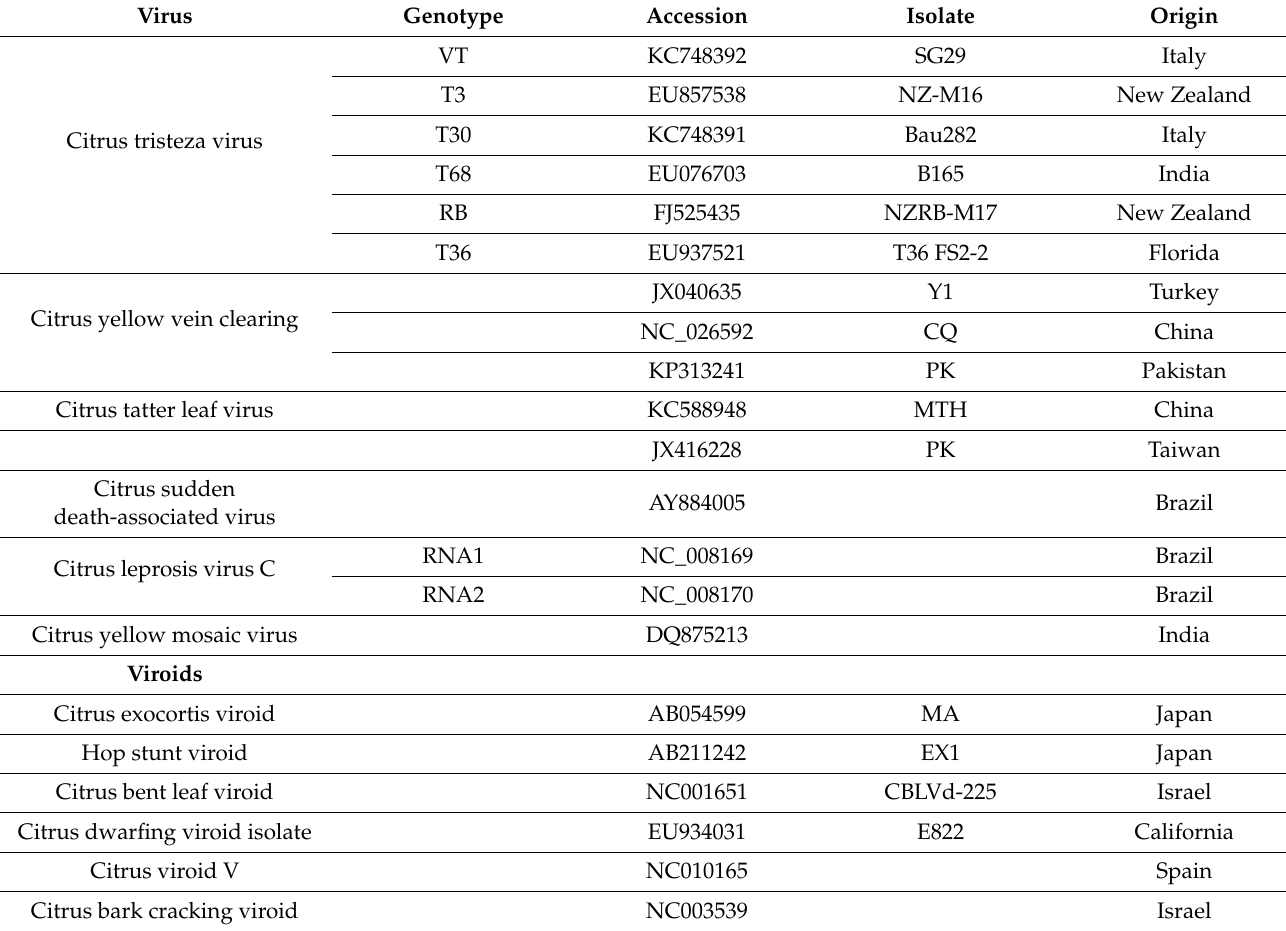
Table 3. List of reference sequences of citrus tristeza virus (one representative genome of each genotype), non-EU viruses and viroids used for genome reconstruction by mapping reads of siRNA